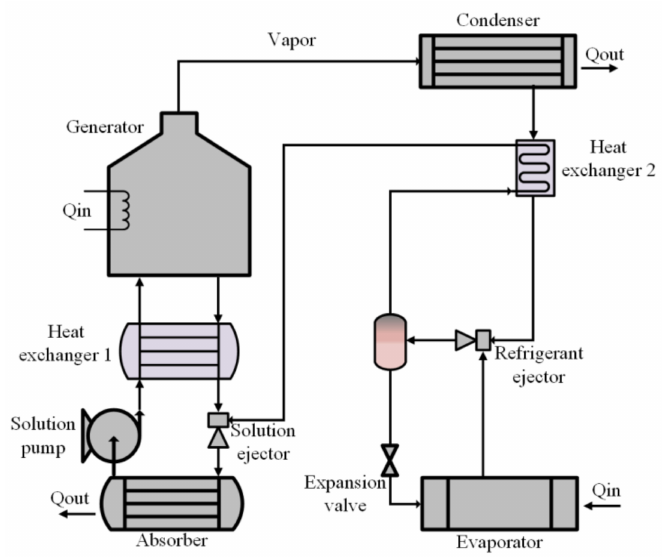
Figure 13. Schematic of DEARS with a separation tank